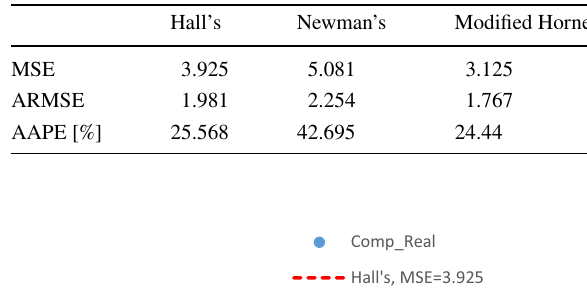
Table 2 Error statistics, laboratory measurements vs